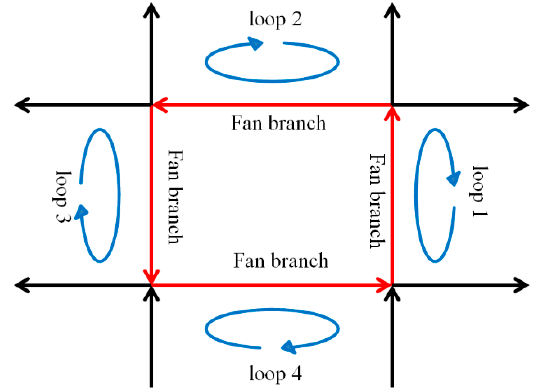
Figure 2. Division of the minimum closed loops with multiple fan branches. As the weight of fan branches is larger than the general branches, each loop contains only one fan branch.